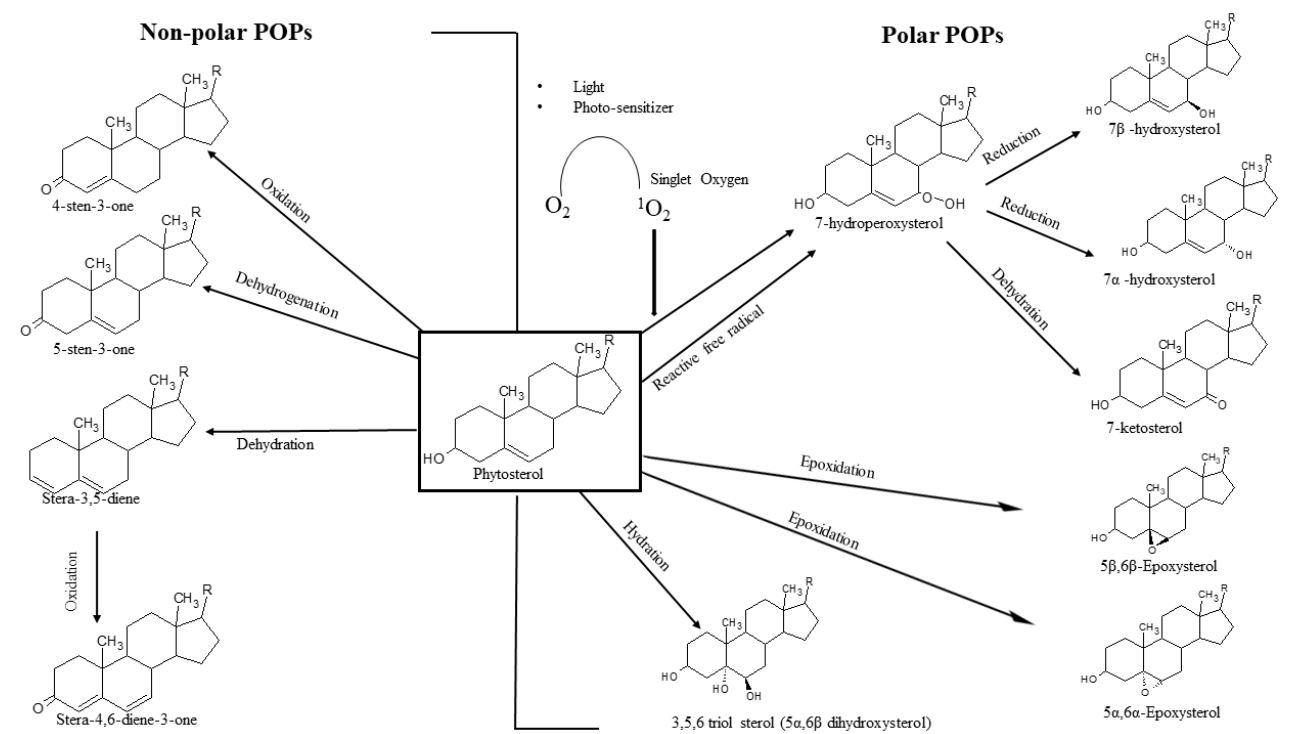
Figure 2. Auto-oxidation and photo-oxidation of phytosterols forming various polar and non-polar phytosterol oxidation products (POPs) [17,18].